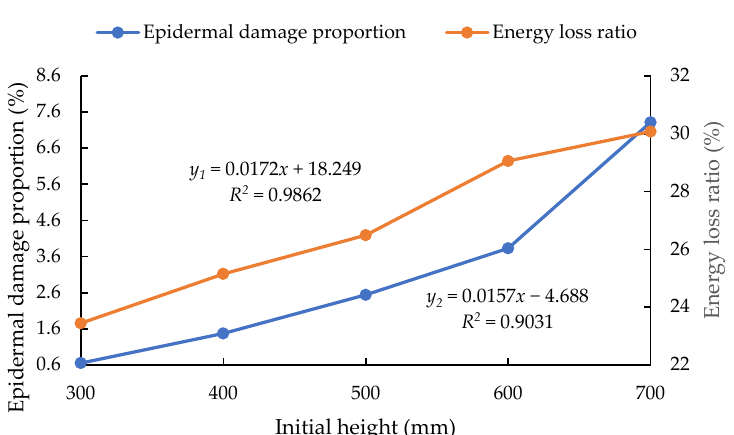
Figure 5. Relationship between initial height and evaluation indexes. Note: The standard deviation range for the proportion of epidermal damage is 0.1 − 0.5, and the standard deviation range for the energy loss ratio is 2 − 6.